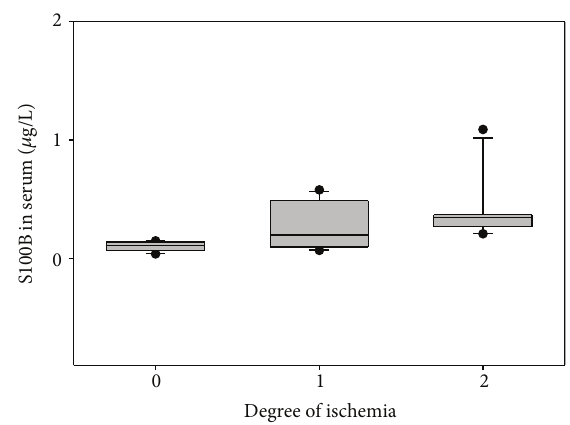
Figure 2: The graph depicts S100B in serum in association with the degree of